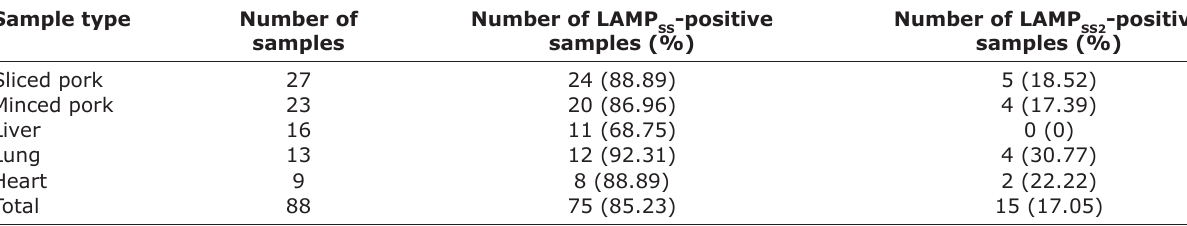
Table-2: Meat samples used in this study and LAMP results.